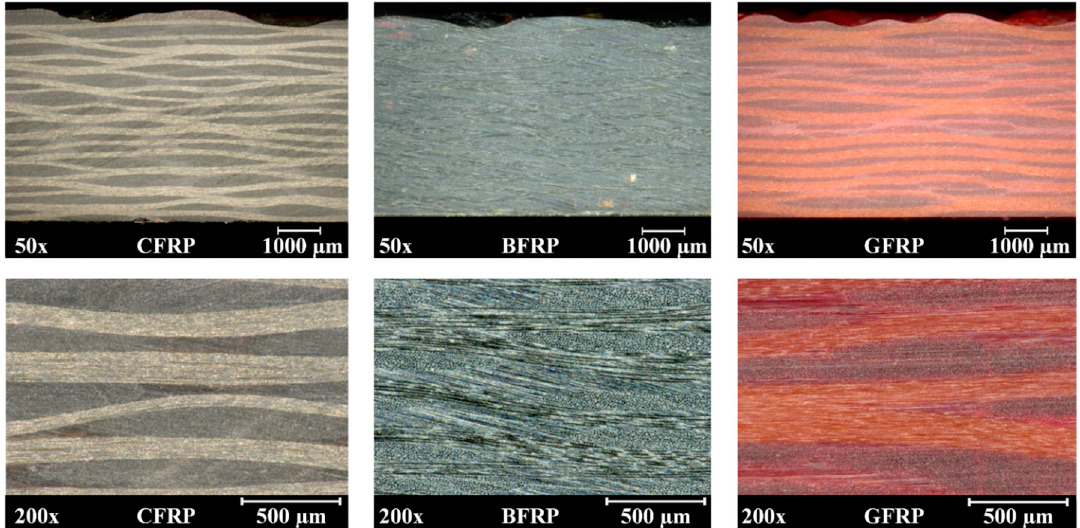
Figure 1. Microscopic images of cross-sections of carbon, glass and basalt fiber reinforced PBF-a with magnifications of 50× and 200×.